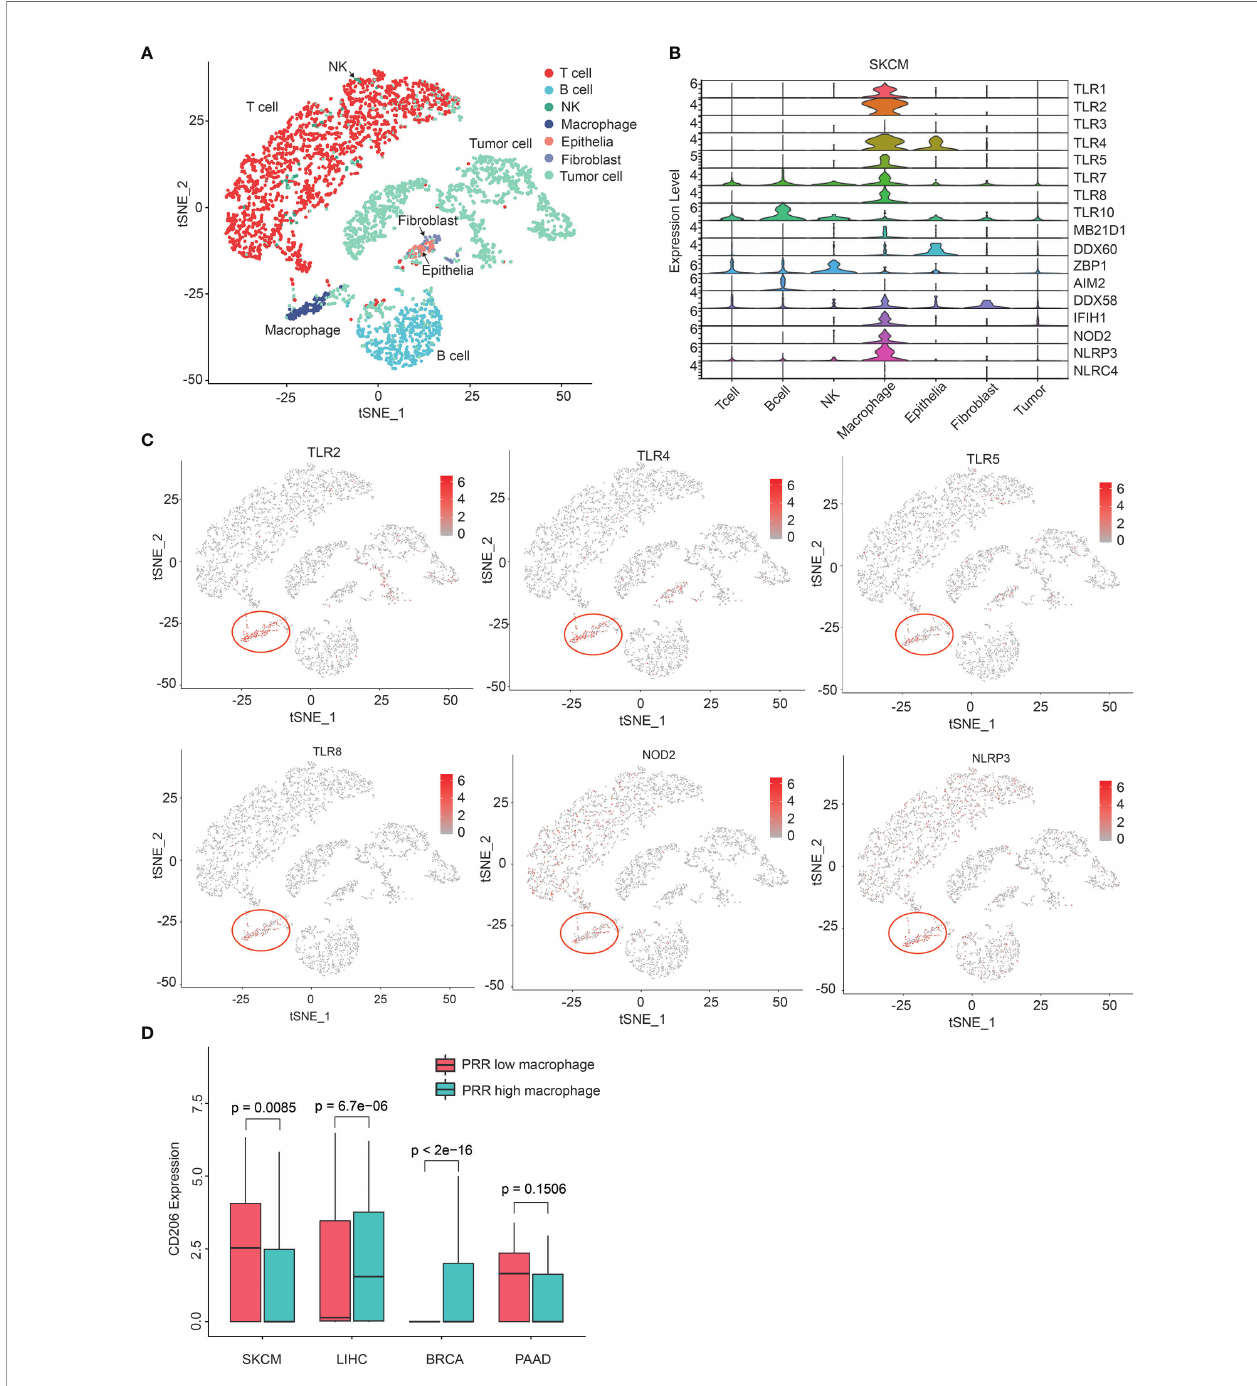
FIGURE 6 | Single cell sequencing analysis reveals PRRs ’ speci fi c expression on macrophages in melanoma. (A) Single-cell expression pro fi les distinguish different cell types in SKCM (tSNE). (B) Single-cell PRR expression pro fi les of different cellular types in SKCM. (C) tSNE graphs show PRRs ’ speci fi cally express on macrophages in SKCM samples. (D) CD206 has a speci fi c low expression in PRR high macrophages only in SKCM samples